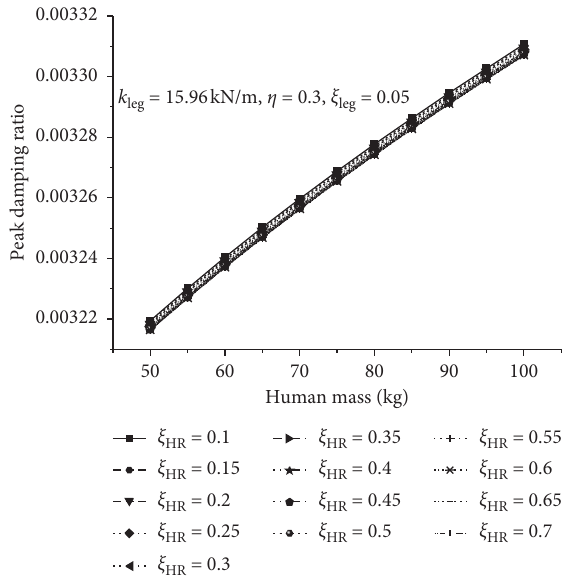
Figure 26: Normalized GRF under different human mass.